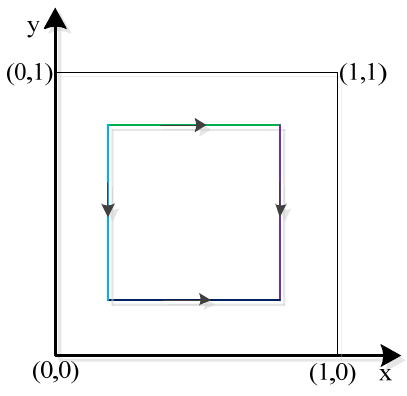
Figure 6. System evolution path of scenario 2.